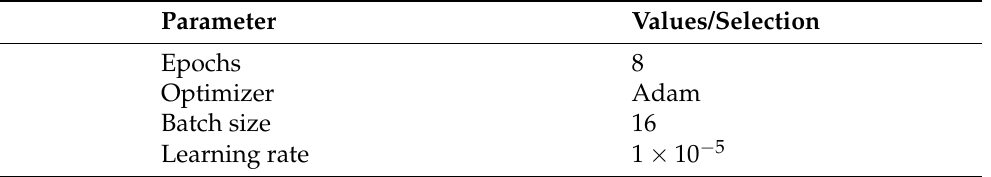
Table 2. Hyperparameter setting.